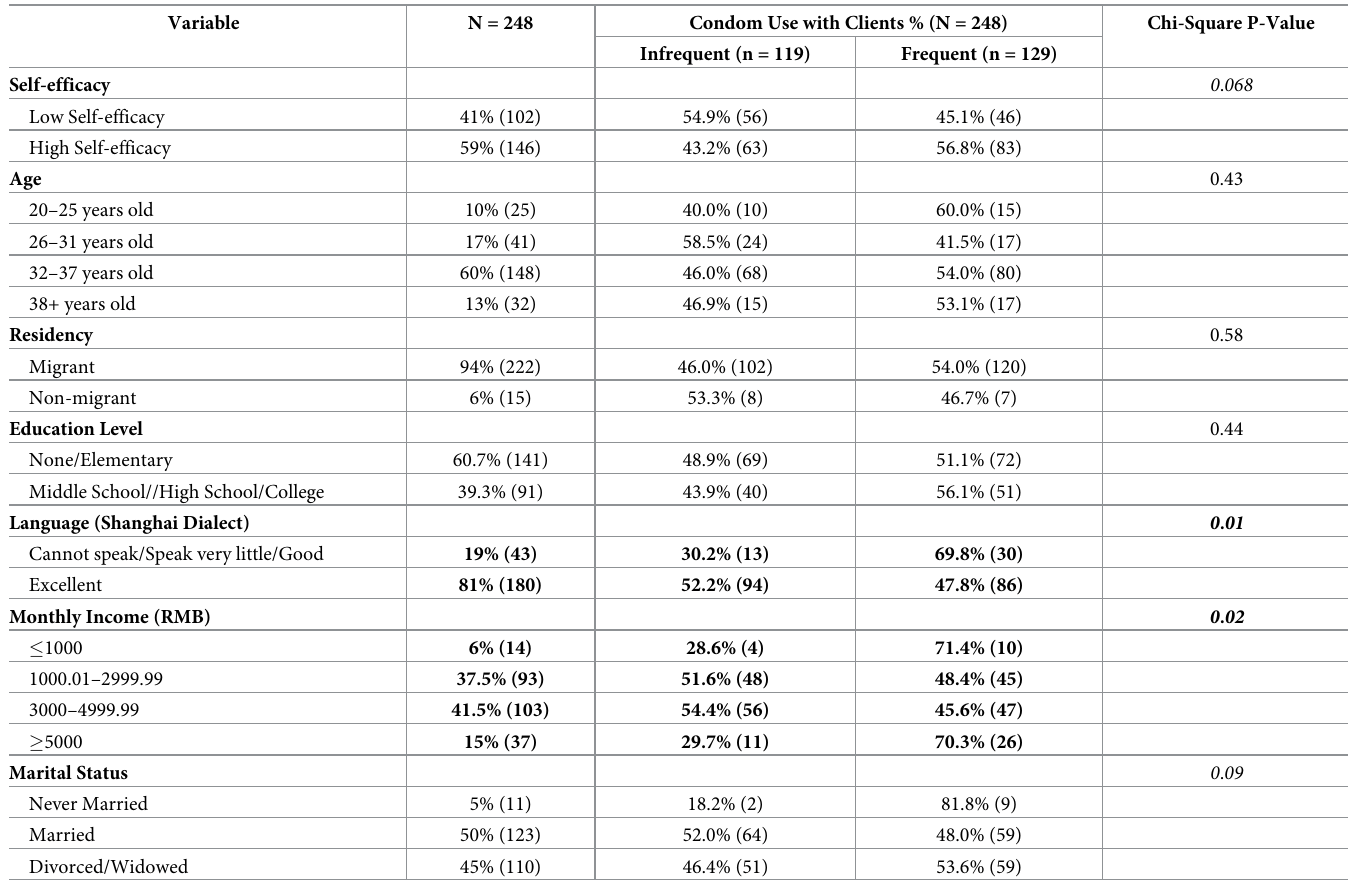
Table 1. Self-efficacy and demographic characteristics and their associations to condom use among street-based female street based sex worker, Shanghai,